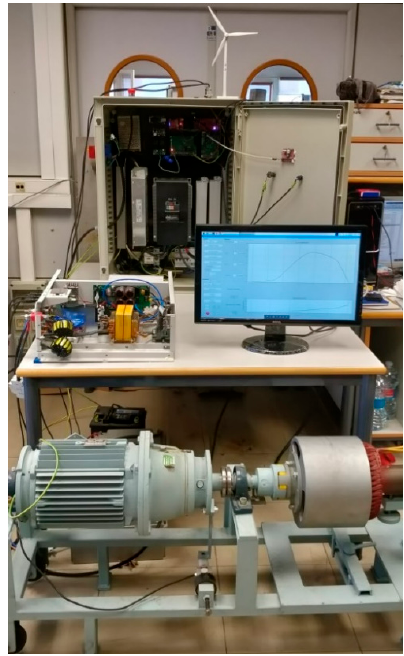
Figure 14. Experimental set up of the small wind turbine emulator system.